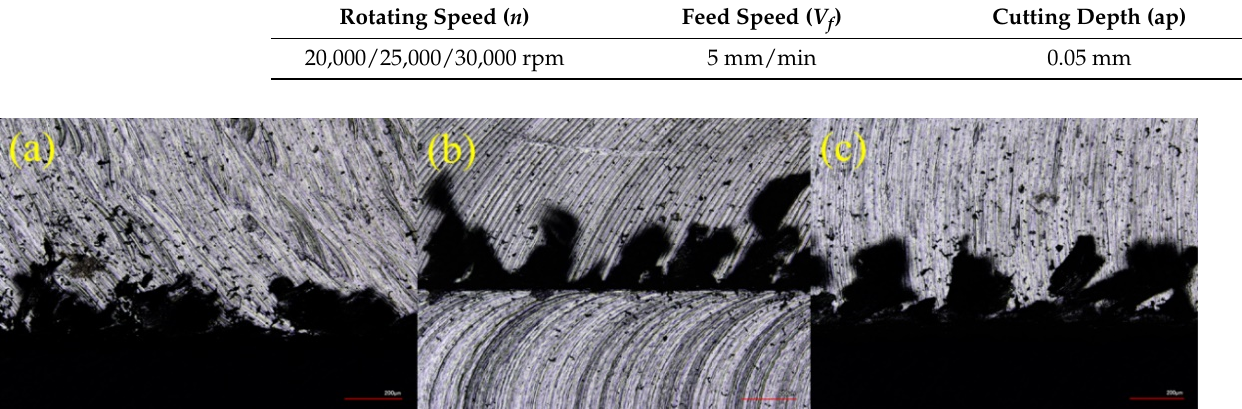
Figure 3. Machined surfaces with different machining parameters ( a ) n = 20,000 rpm, ( b ) n = 25,000 Figure rpm, and ( c ) n = 30,000 rpm.